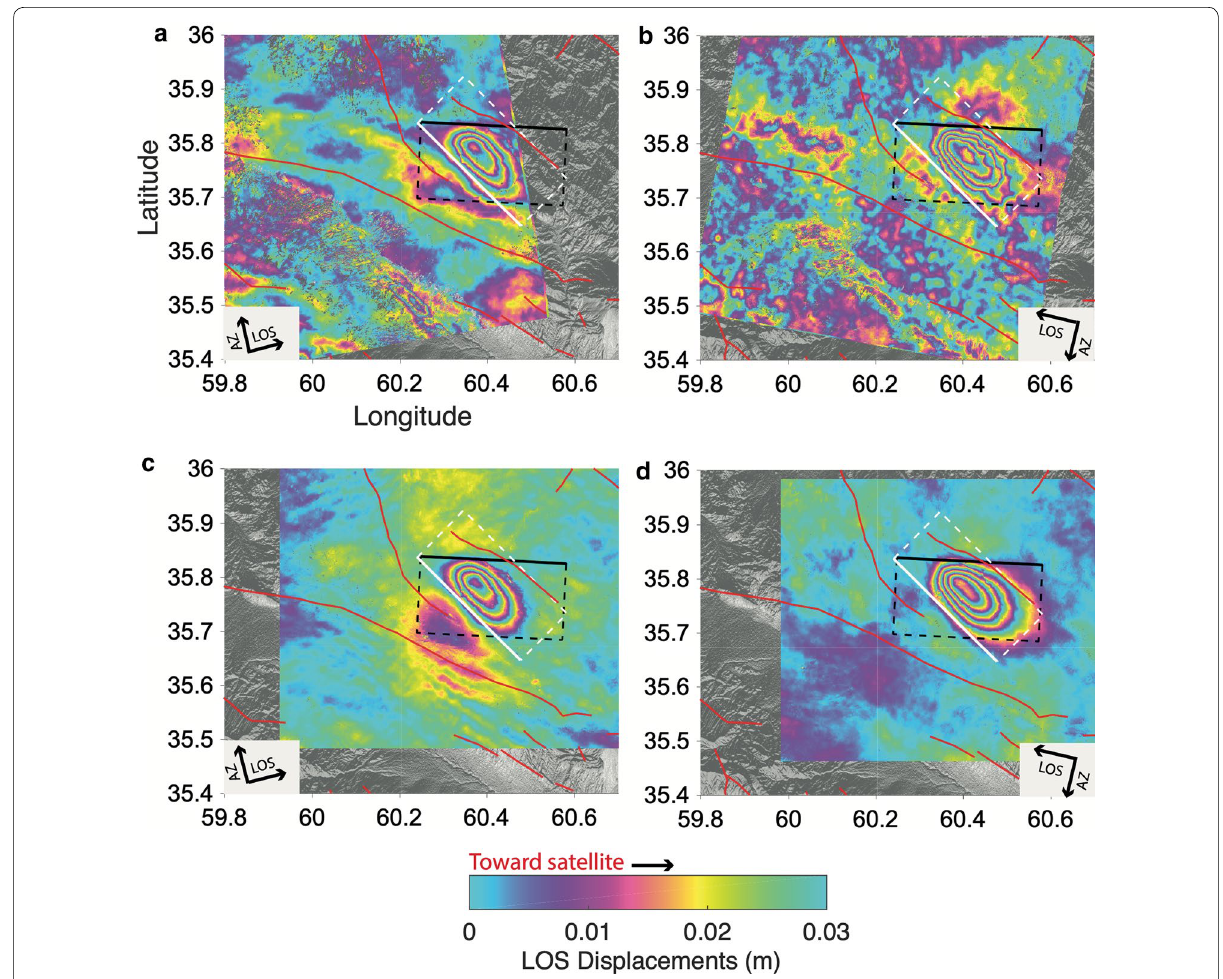
Fig. 3 Same as Fig. 2, except that atmospheric corrections have been